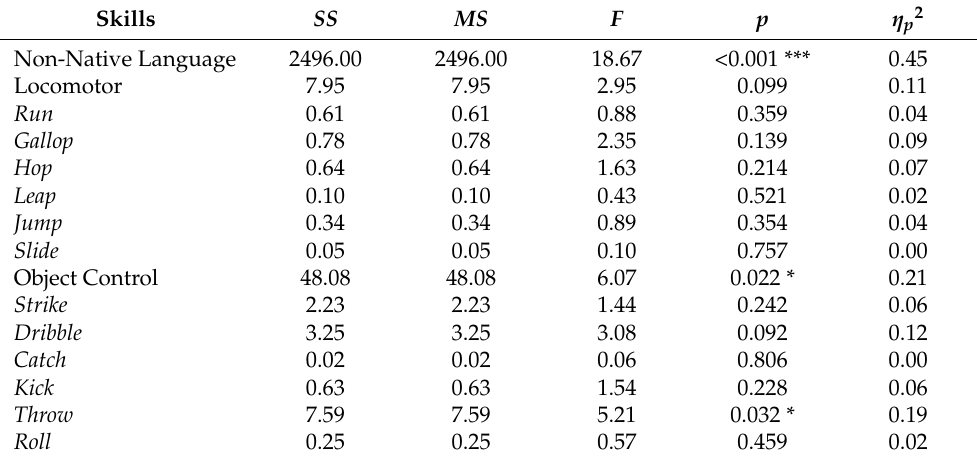
Table 3. Analysis of covariance ( ANCOVA ) for the non-native language and motor skills by group condition (control vs. experimental group). The result of the pre-test was set as the